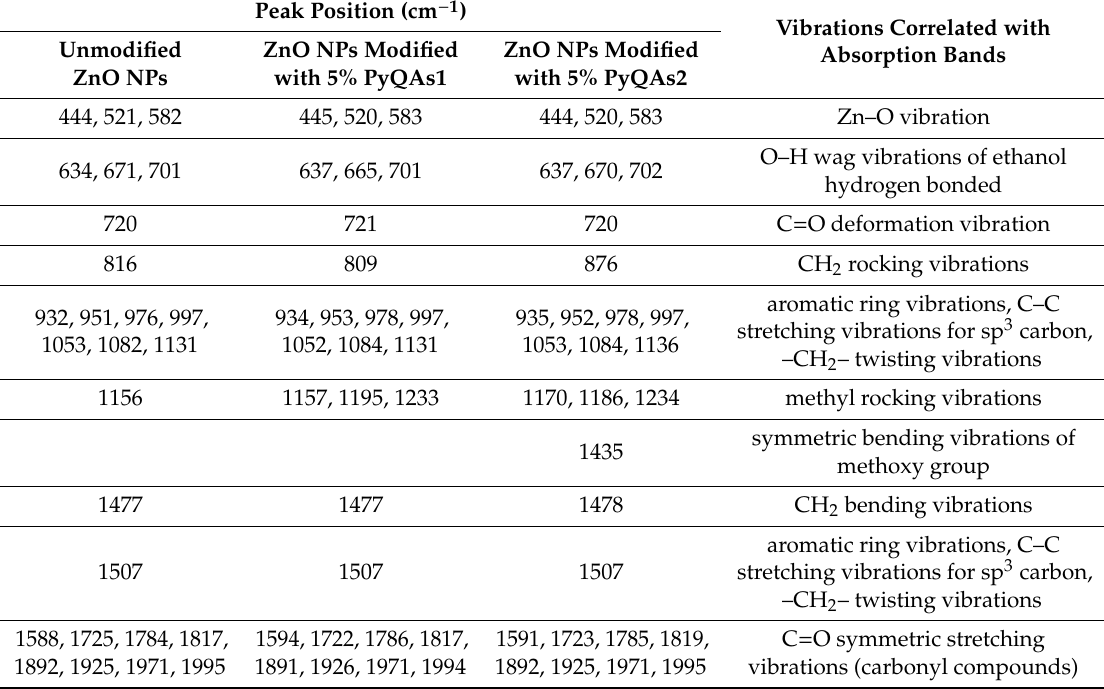
Figure 8. Raman spectra of ZnO NPs obtained without PyQAs2 ( a ) and with 5% PyQAs2 ( b ). Table 4. Correlations of peaks positions in the Raman spectra of formed ZnO NPs with vibrations of functional groups [41,42]